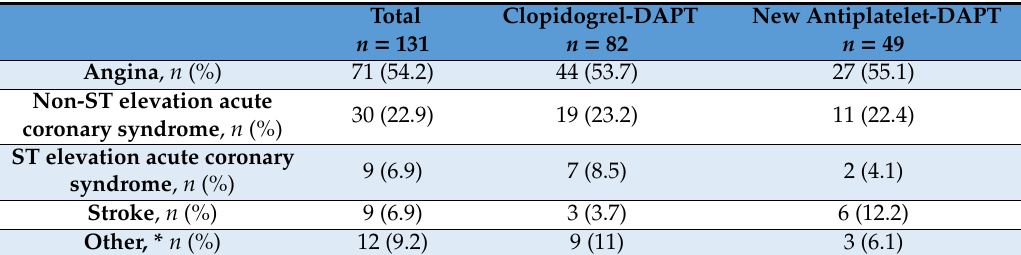
Table A2. Ischemic and other cardiovascular